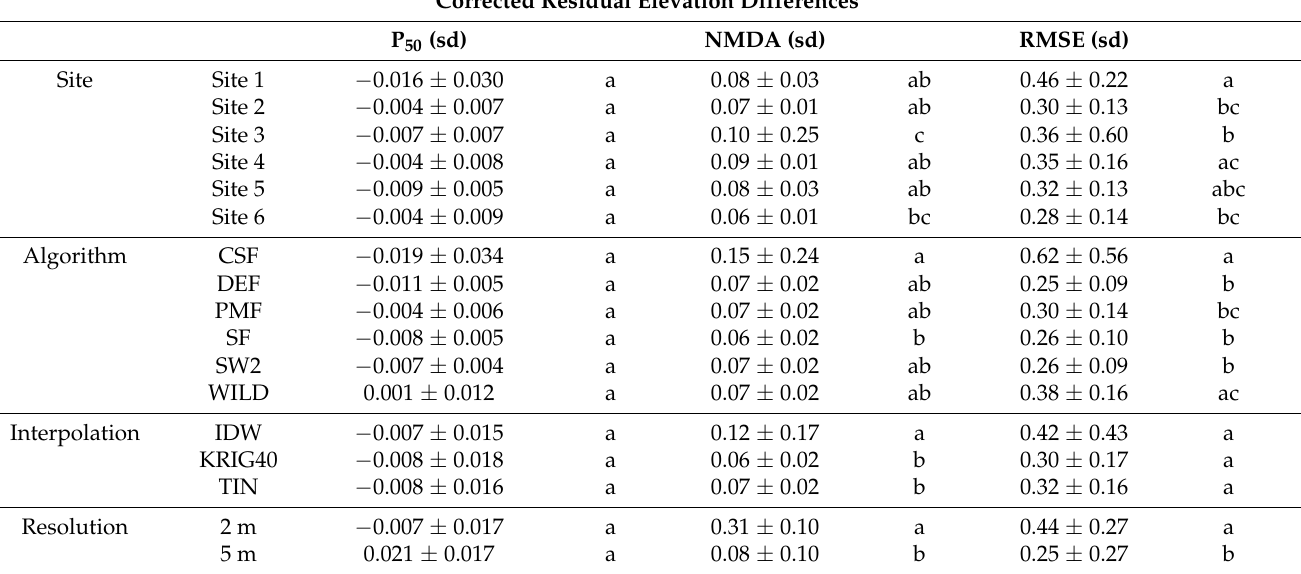
Table 6. Mean and standard deviation of corrected elevation errors (i.e., DEMs of differences) measured by the 50th percentile (P 50 ), the normalized median absolute deviation (NMAD) and the root mean square error (RMSE) grouping by sites (sites), classification filters, interpolation methods and spatial resolutions. Letters indicated significant differences within groups according to the post hoc Dunn ´ s non-parametric test for Kruskal-type ranked data with a significance level of p < 0.05. Corrected Residual Elevation